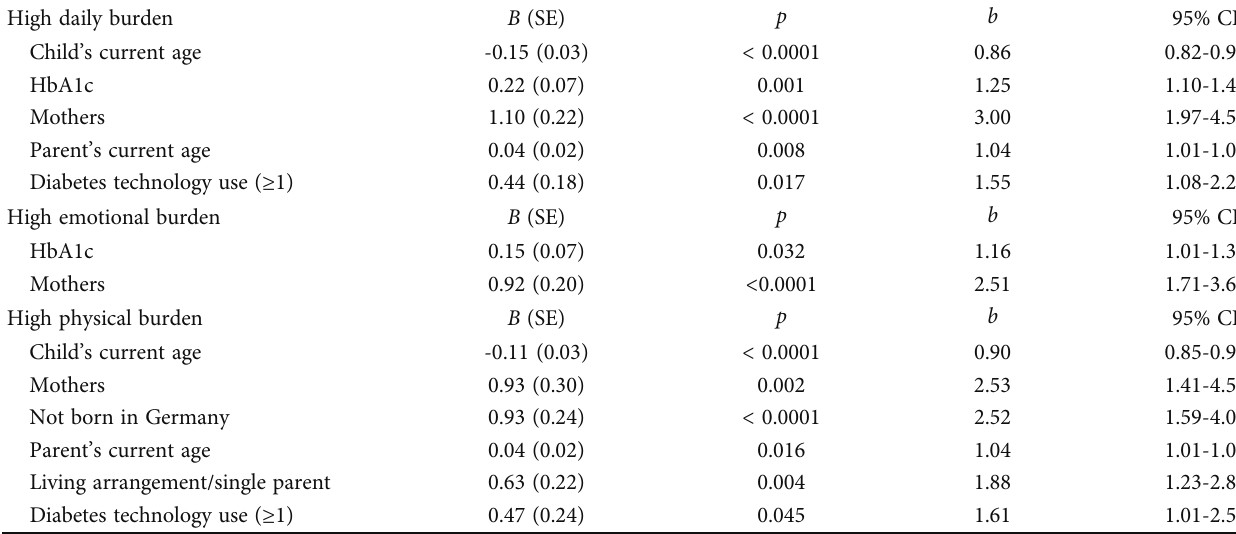
Table 3: Three exploratory logistic regressions of daily, emotional, and physical burdens of parents living with a child with type 1 diabetes. High daily burden